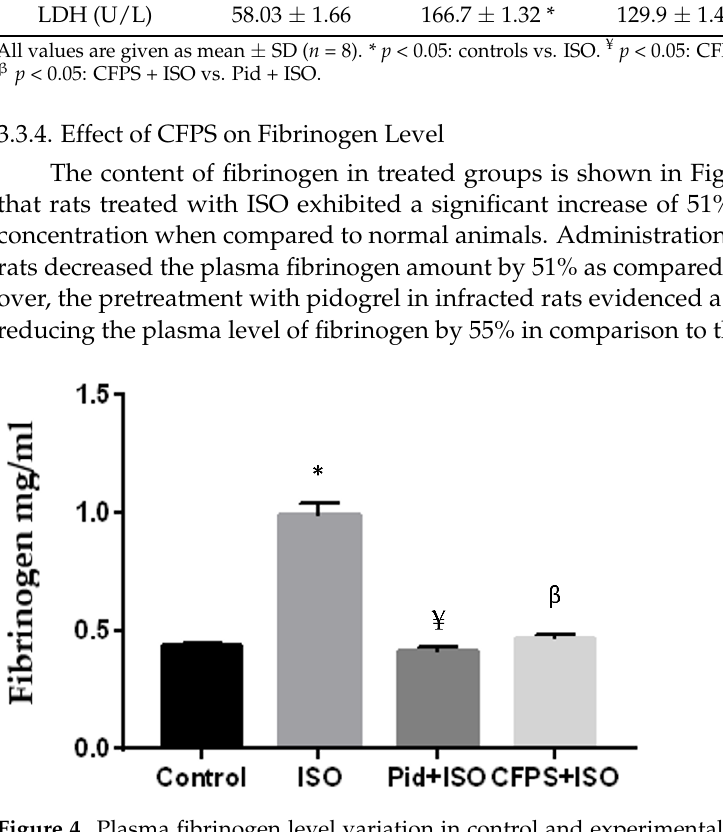
Table 5. Effect of CFPS fraction on lipidic